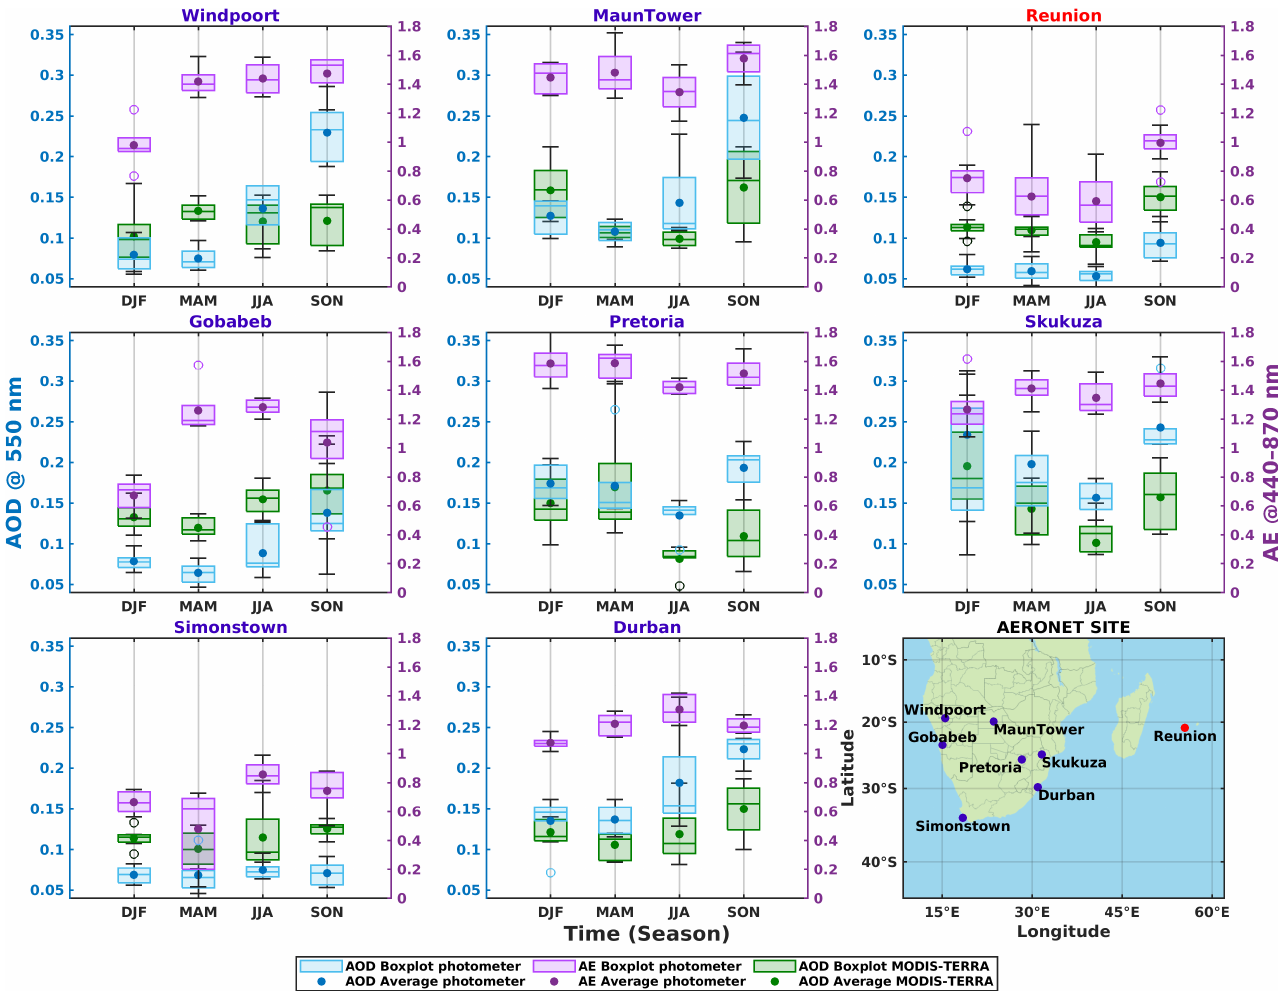
Figure 5. Multiyear seasonal average (±1 standard deviation) of AOD at 550 nm (blue for sun photometer and green for MODIS observations) on the left vertical axis and AE at 440–870 nm (purple) on the right vertical axis over the eight sun photometer sites. The colored box diagrams for each season are December to February (DJF), March to May (MAM), June to August (JJA), and September to November (SON). The median is the central value (the line inside the boxes). The edges of the boxes are set at the 25th and 75th percentiles. The whiskers show the extreme values, excluding outliers, which are represented by shaded colored circles. Filled colored dots indicate average